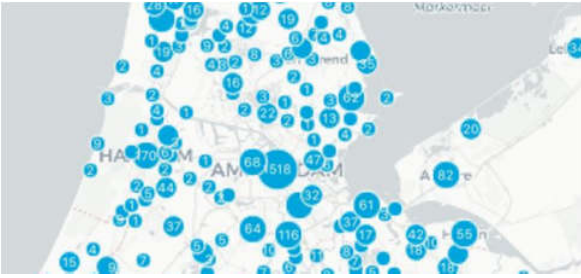
Figure 3 . Readability losing on medium zoom level when applying anchor-points-based clustering approach.